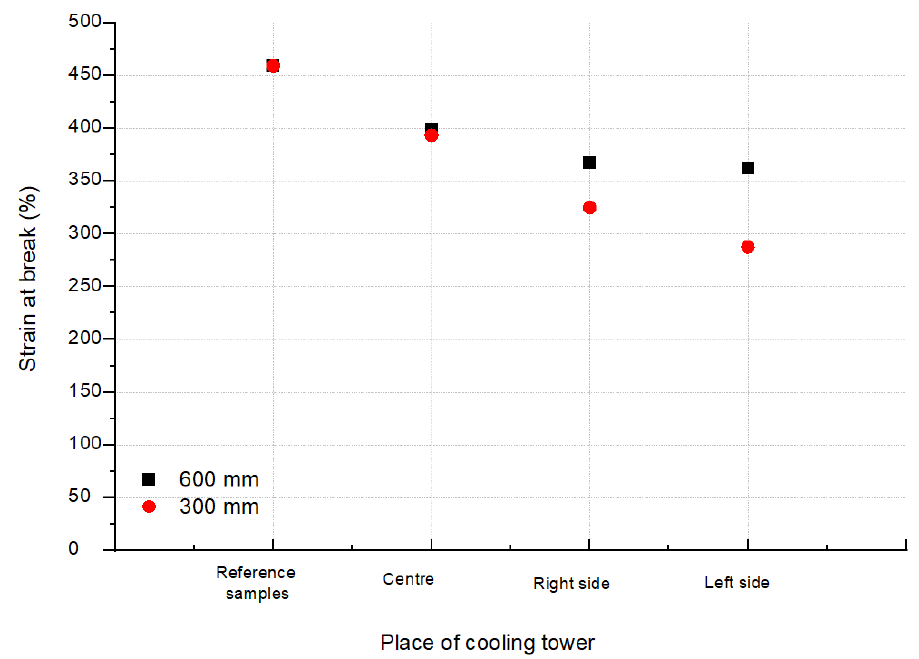
Figure 12. Strain at break from blocks positioned as shown in Figure 2 for